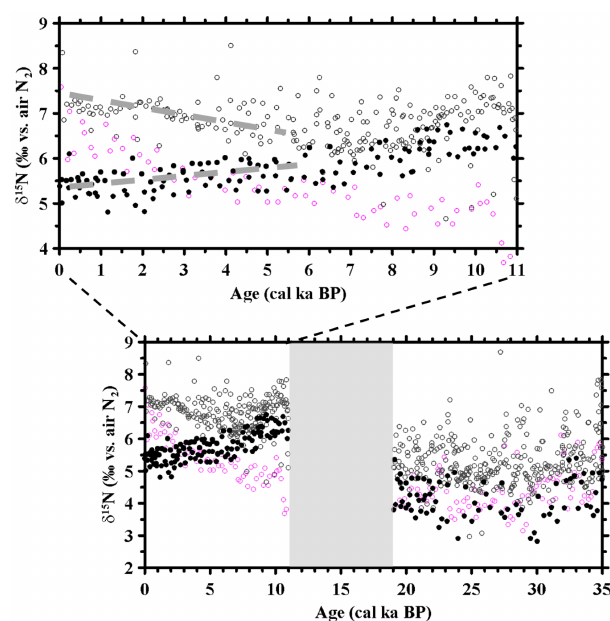
Figure 9. Temporal variations of corrected δ 15 N bulk values of all reported cores in the AS. Gray and black dots are for the northern and southern AS, respectively. Pink dots are specifically for core MD-04-2876. The deglacial period is in shadow because non proper equations for bottom-depth effect correction. The upper panel is the blow-up for the Holocene period. The intensified deviation trends since 6ka were marked by bold dashed